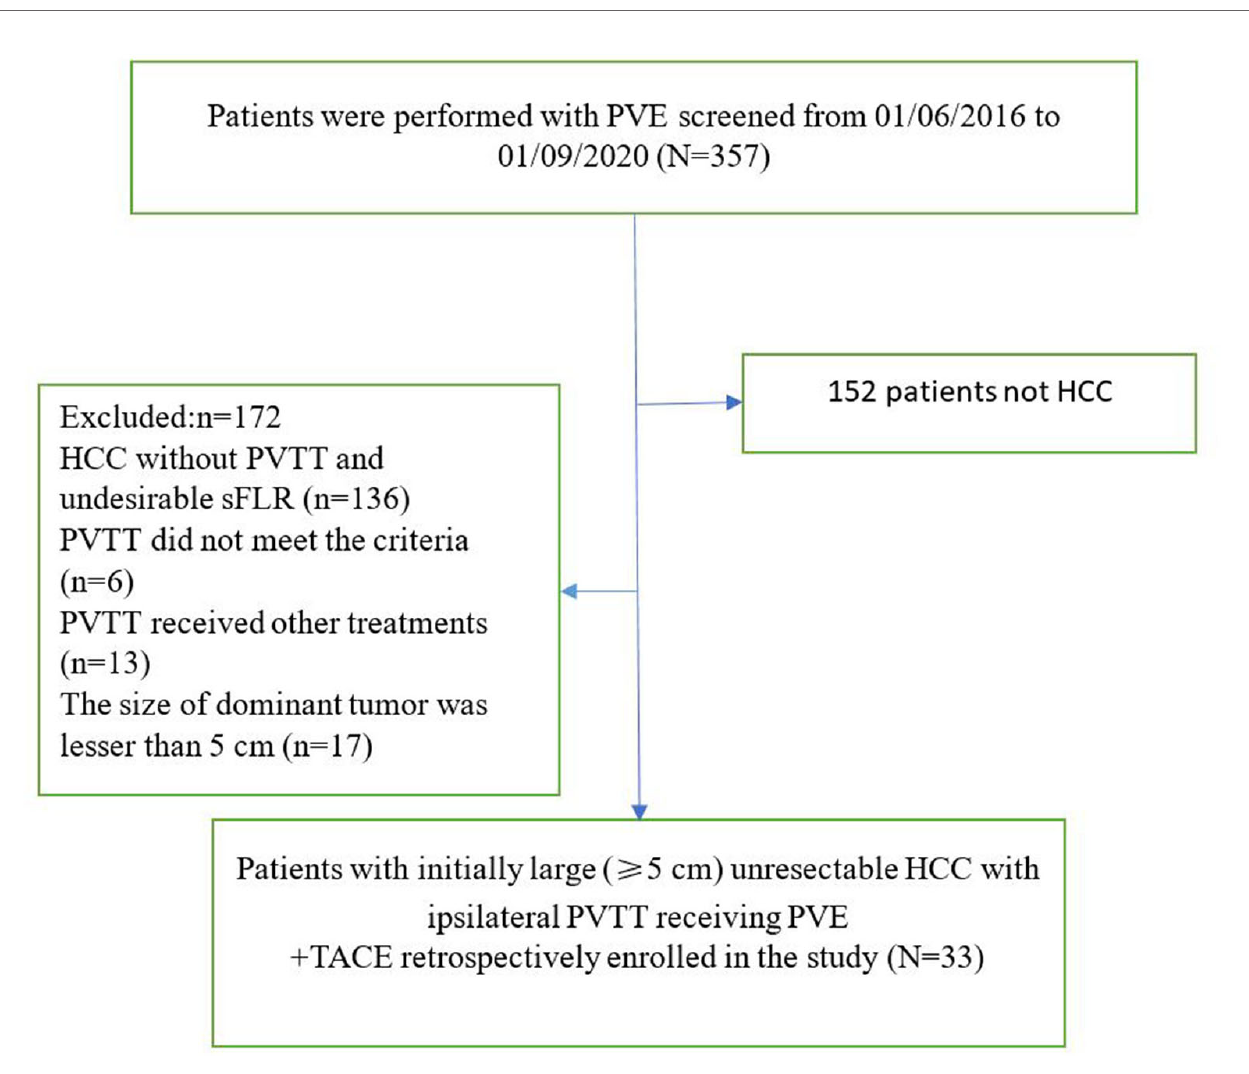
FIGURE 3 | The fl ow diagram of patients (PVE + TACE group). PVE, portal vein embolization; HCC, hepatocellular carcinoma; PVTT, portal vein tumor thrombus; sFLR, standized future liver remnant; TACE, transarterial